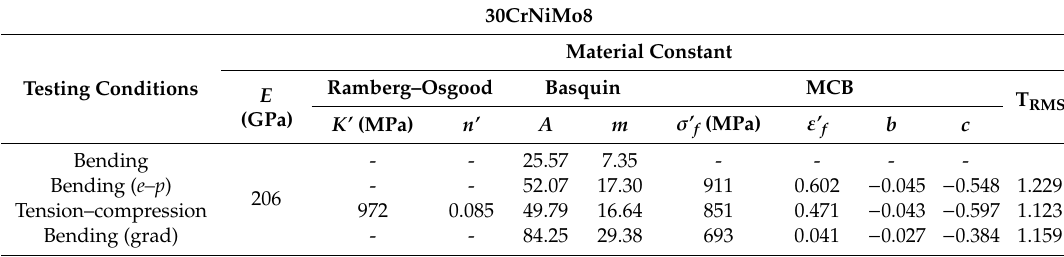
Table 4. Cyclic properties of 30CrNiMo3